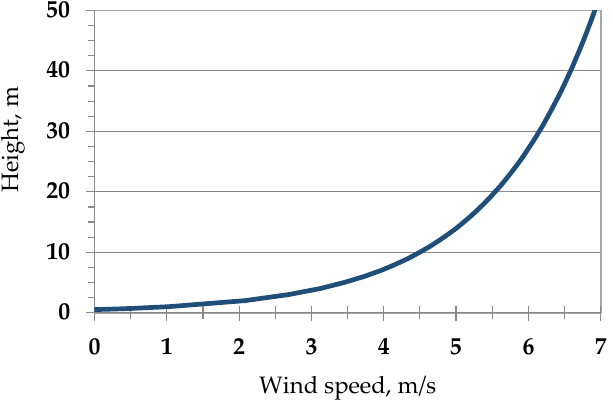
Figure 4. Wind profile used for CFD simulations.